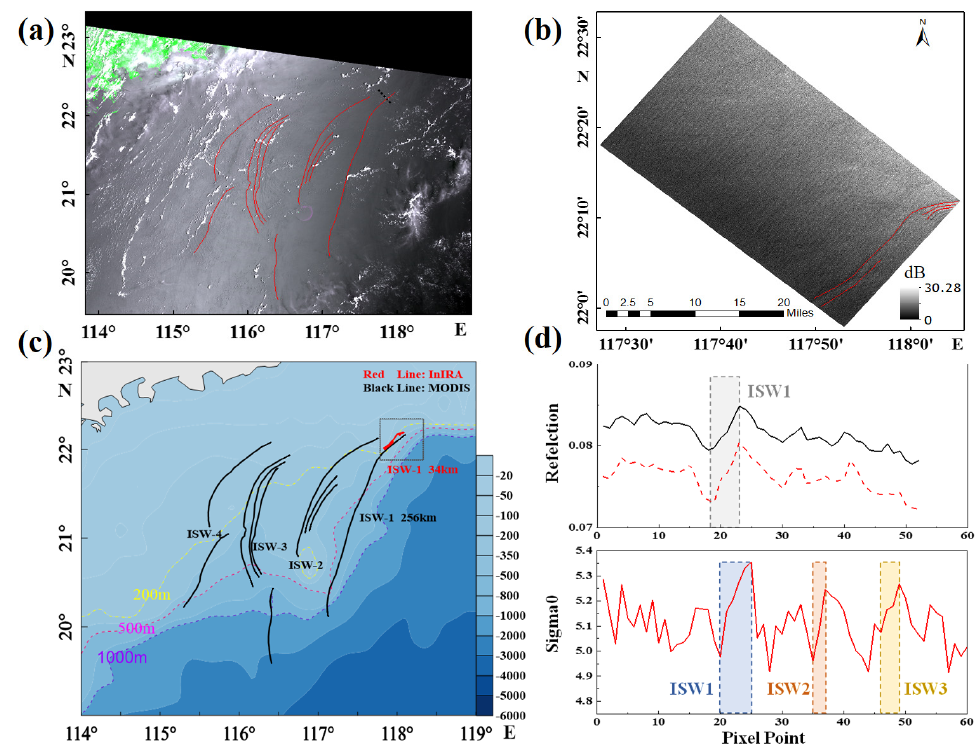
Figure 5. Comparison of the abilities of InIRA and MODIS to detect ISWs. ( a ) MODIS image acquired at 03:10 UTC on 12 August 2017; the crest lines are shown as red solid lines. ( b ) InIRA image acquired at 14:18 UTC on 12 August 2017. ( c ) ISWs from the two images superposed; the black (red) solid lines are the crest lines of the ISWs from the MODIS (InIRA) image. The number of the ISW is represented by “ISWS-X” (X being the number from 1 to 4), the gray box is the overlapping area between the two images, and the colored dashed lines are water depth contours. ( d ) Profiles drawn along the vertical direction of the ISW crest line (black dashed line in Figure 5a,b); the upper (lower) panel is from the MODIS (InIRA)